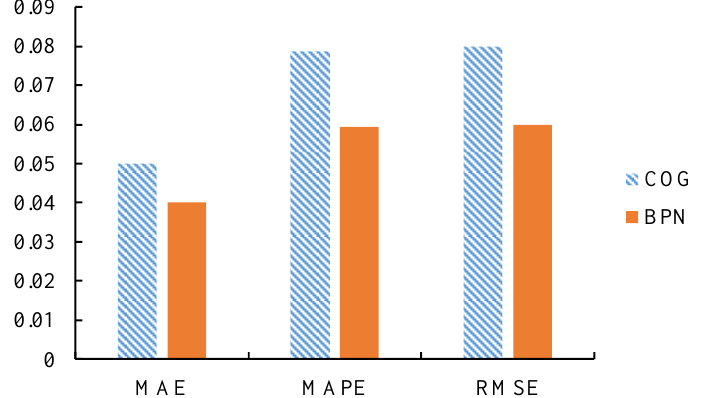
Figure 13. Forecasting performance for the proposed methodology with different defuzzifiers.